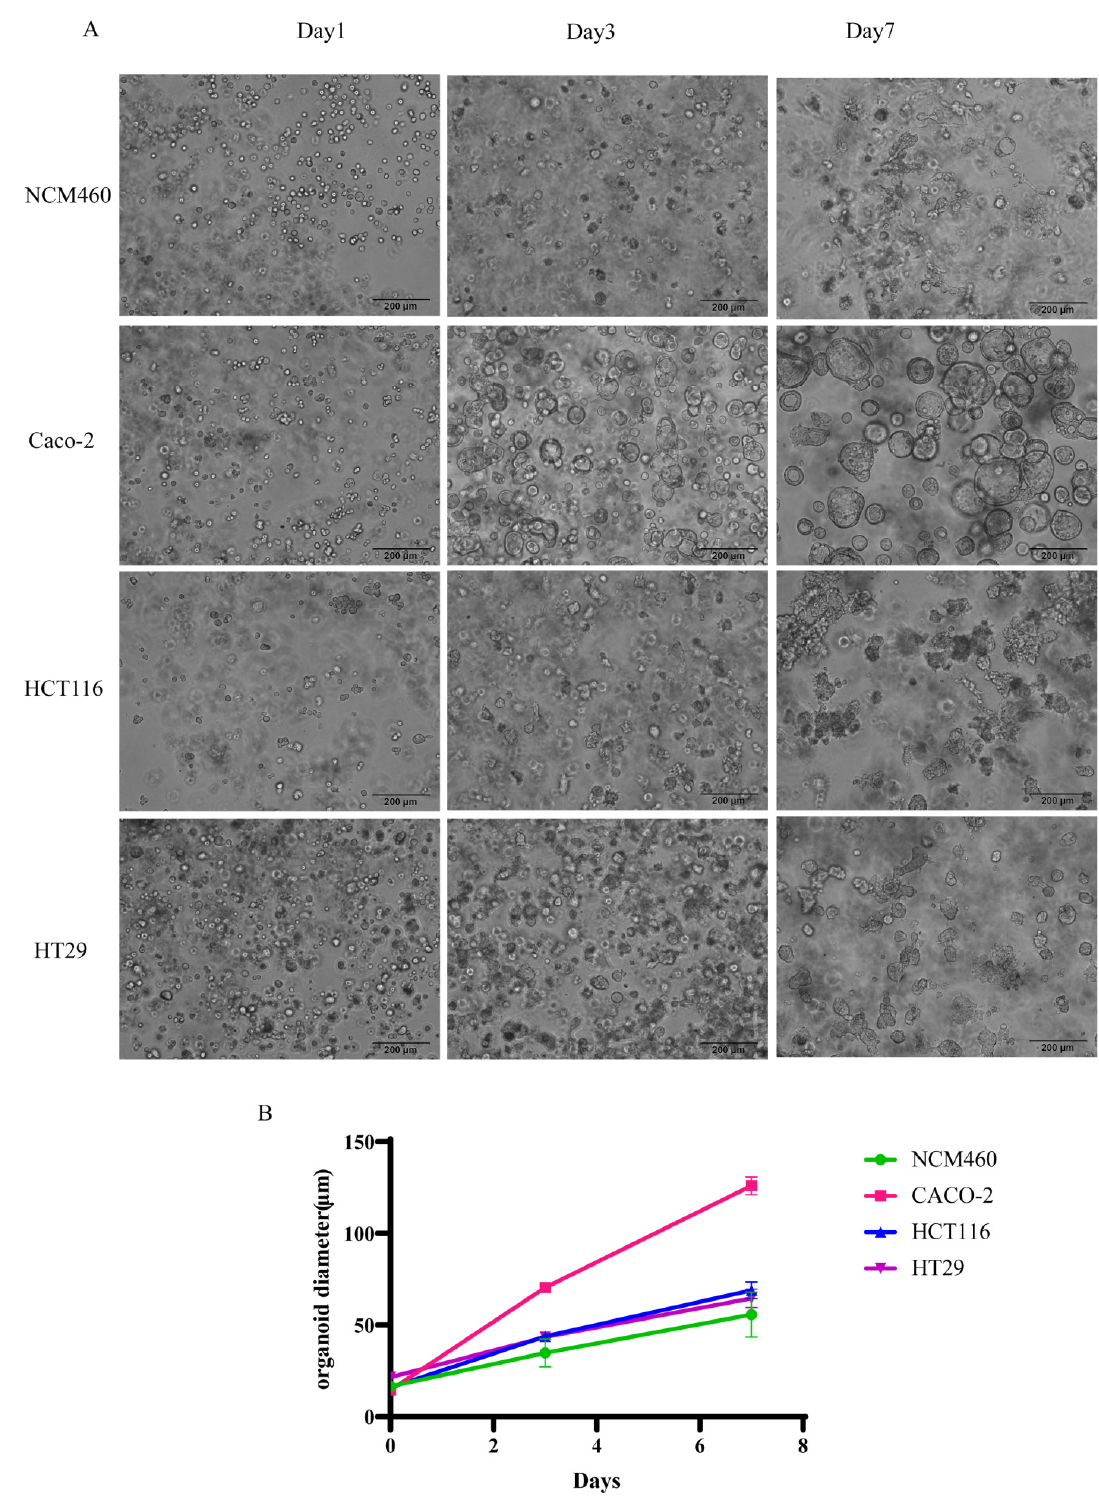
Figure 4. Morphology and growth curve analysis of organoids in the SAP-Matrix. ( A ) Microscopic morphology of organoids of NCM460, Caco-2, HCT116, and HT29 on day 1, 3, and 7; ( B ) growth curve trend of organoids of NCM460, Caco-2, HCT116, and HT29 in 7 days.